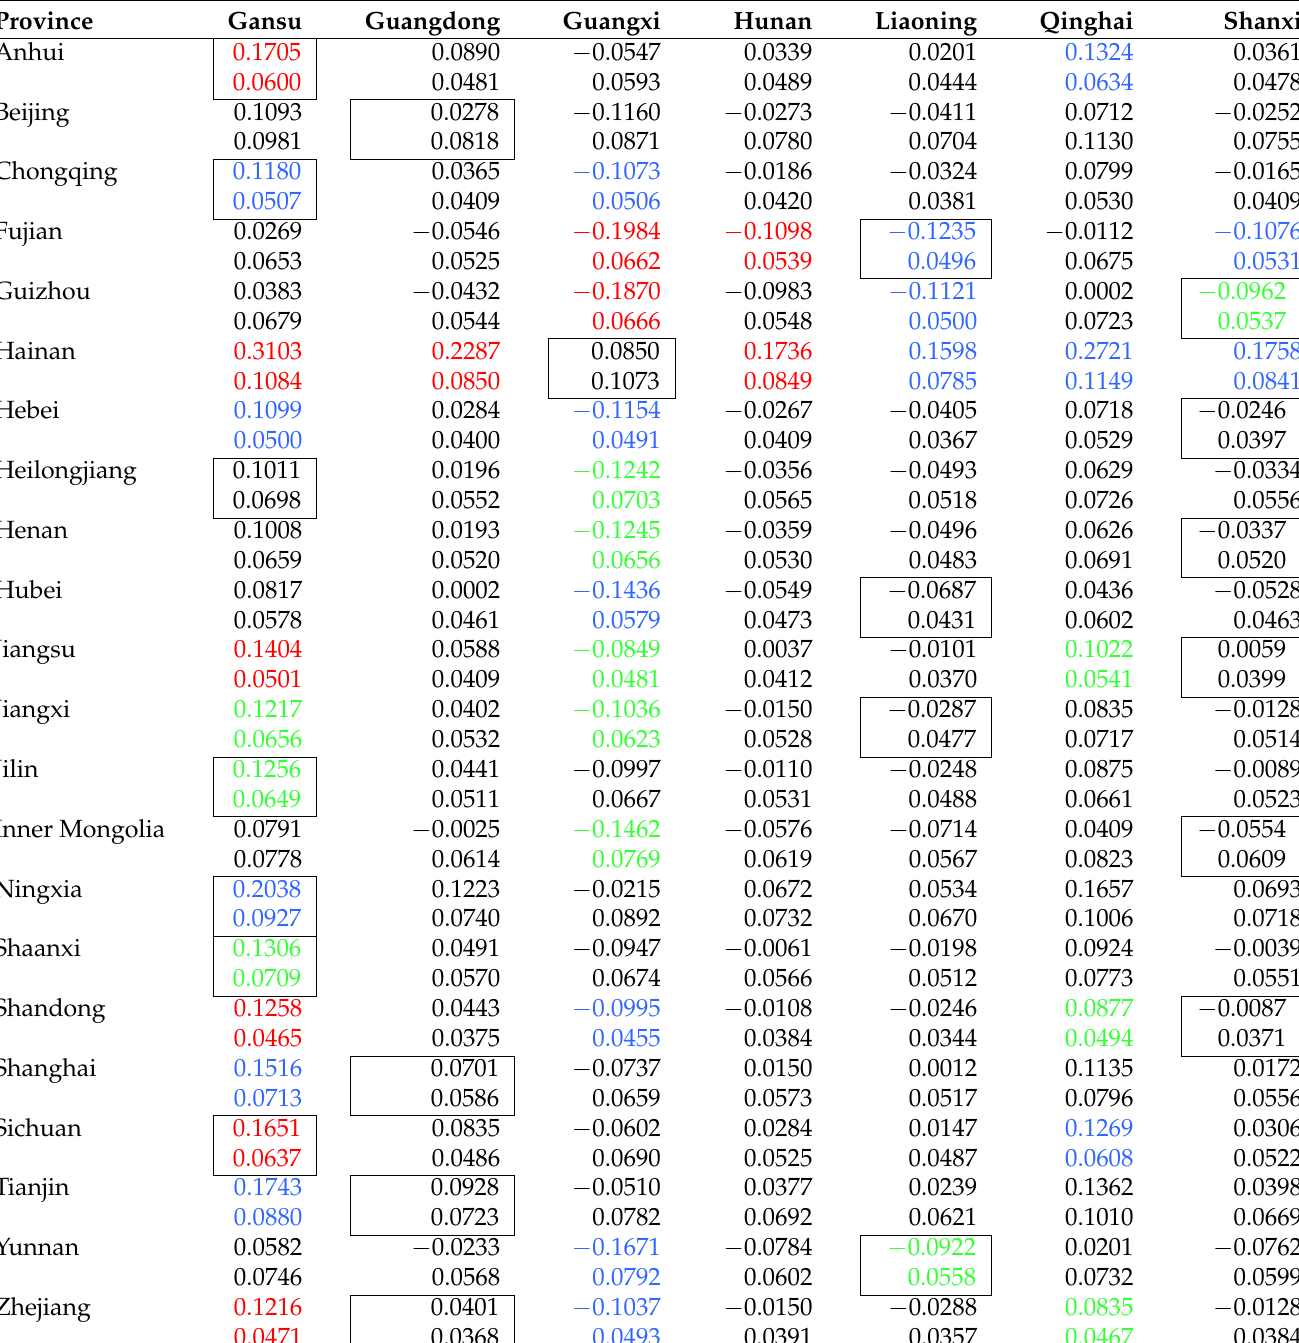
Table 9. ATET estimates (with corresponding standard error listed beneath) for each treated (row) vs. each (column) control province (for all families where primary school is the highest level of education) for if they were planning to buy a home: Significance of point estimates at the arbitrary 1, 5, and 10 percent levels are colored red, blue, and green, respectively—a box is given for the control province most closely aligned with the treatment province in terms of absolute minimum